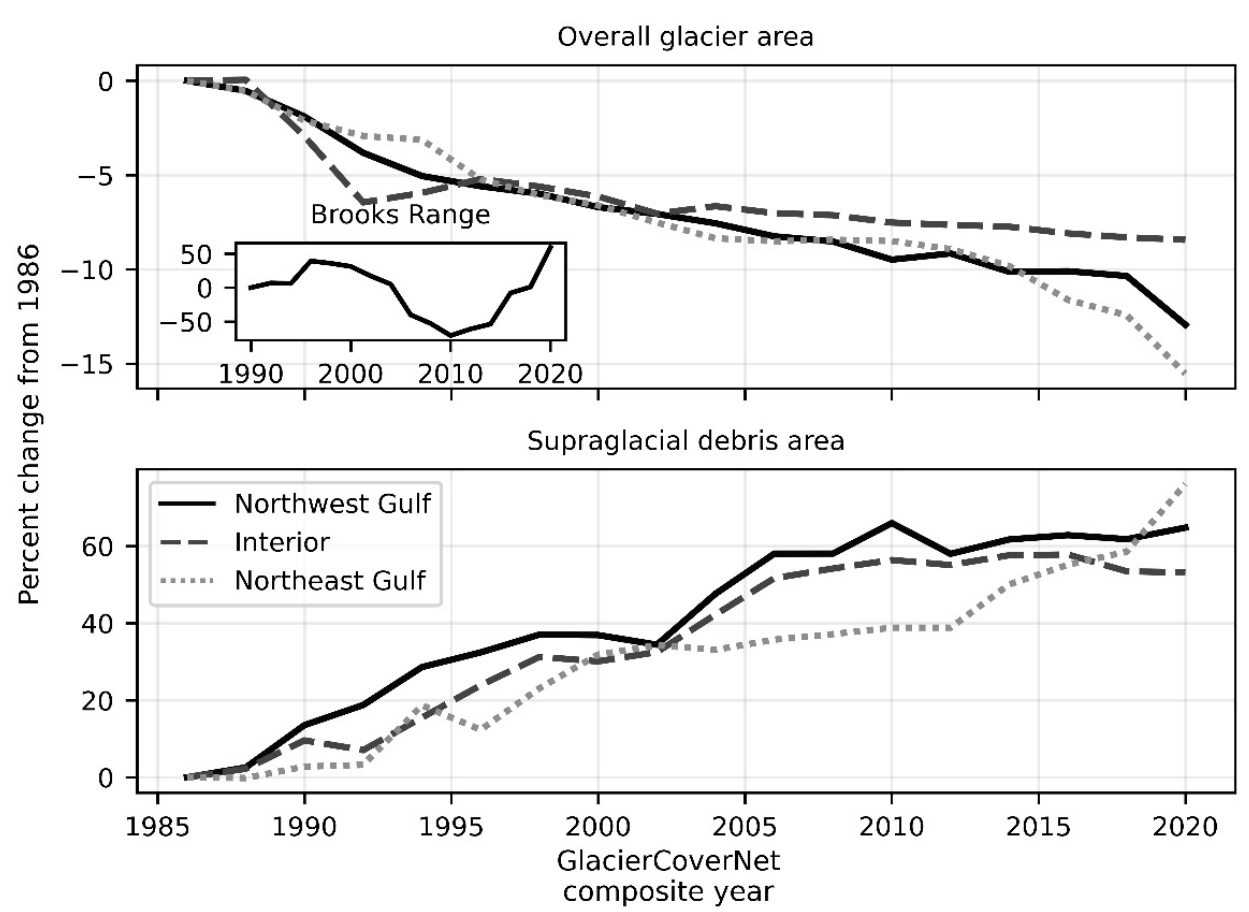
Figure 4. Change in overall glacier area ( top ) and area of supraglacial debris ( bottom ) for the period 1985–2020. Y-axis values are calculated as the percentage change from a 1986 composite baseline. The Brooks Range is included as an inset ( top ) and uses 1990 as a baseline due to higher uncertainty in this region, particularly early in the time series (Appendix A.2). Table 2. Summary of climate division aggregations of Mann–Kandell (MK) trend test results and Theil–Sen slope (km 2 /2 years) for aggregated regions with statistically significant trends. Additional area values are included in Appendix A.2.